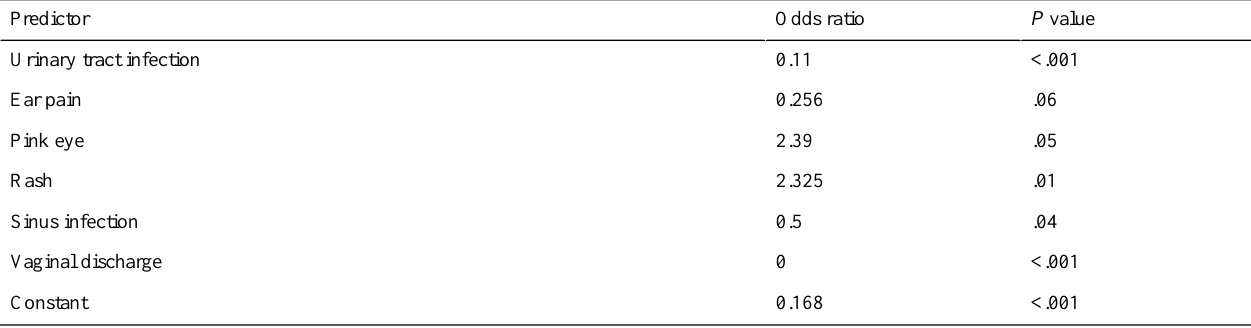
Table 3. Odds ratio and significance ( P value) of the chief concern predictor a .